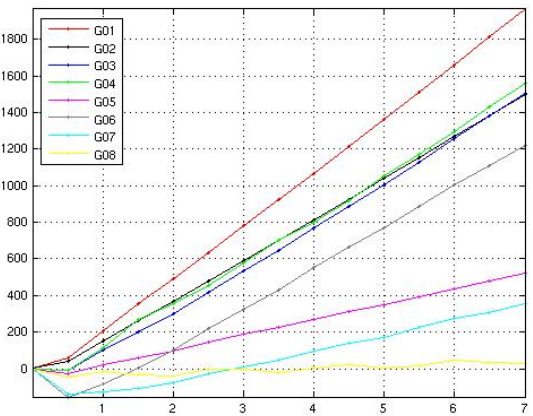
Fig. 5. Down-slope displacement of the centre of gravity of the gravity current in the 2.5-D experiments during the first 7 days of the experiments. Vertical axis in metres and horizontal axis in days.